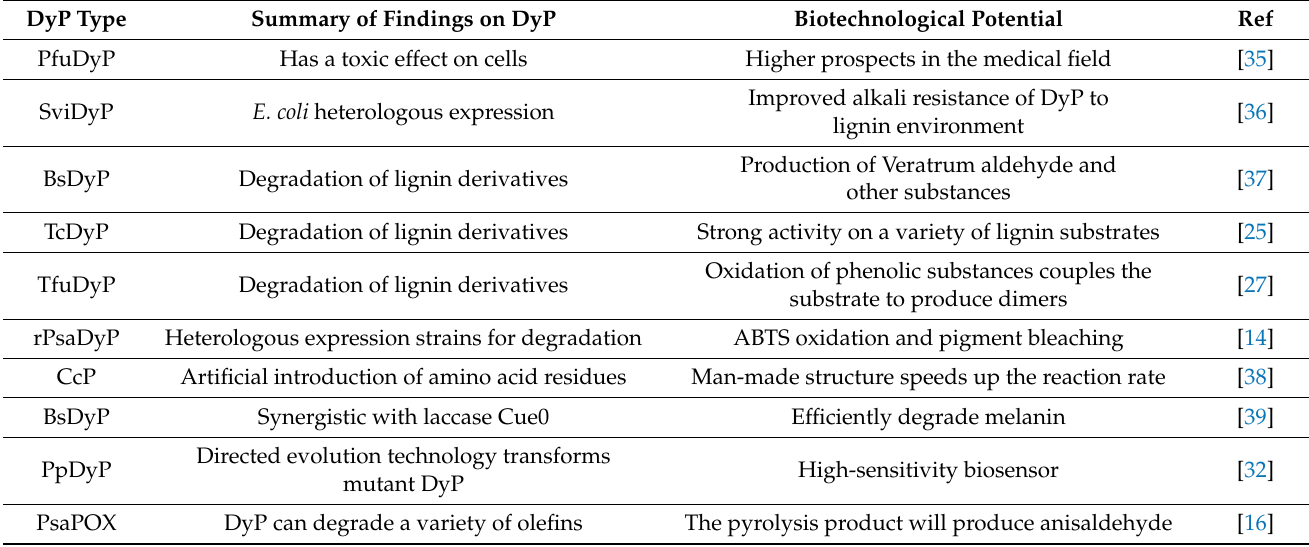
Table 1. DyP biological characteristics and application